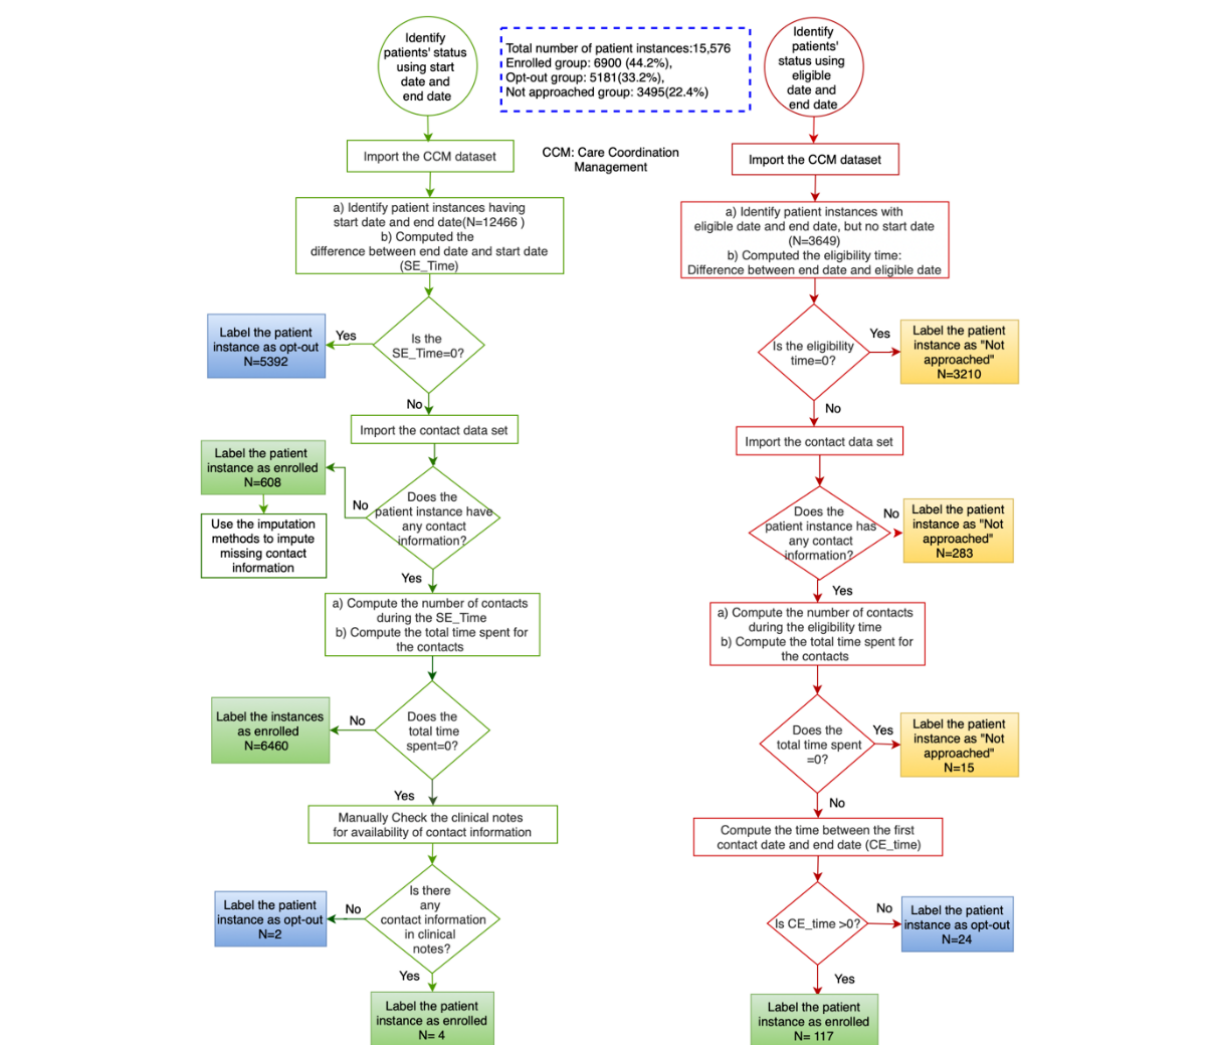
Figure 2. Identifying patient subgroups in the depression registry. CCM: collaborative care model.